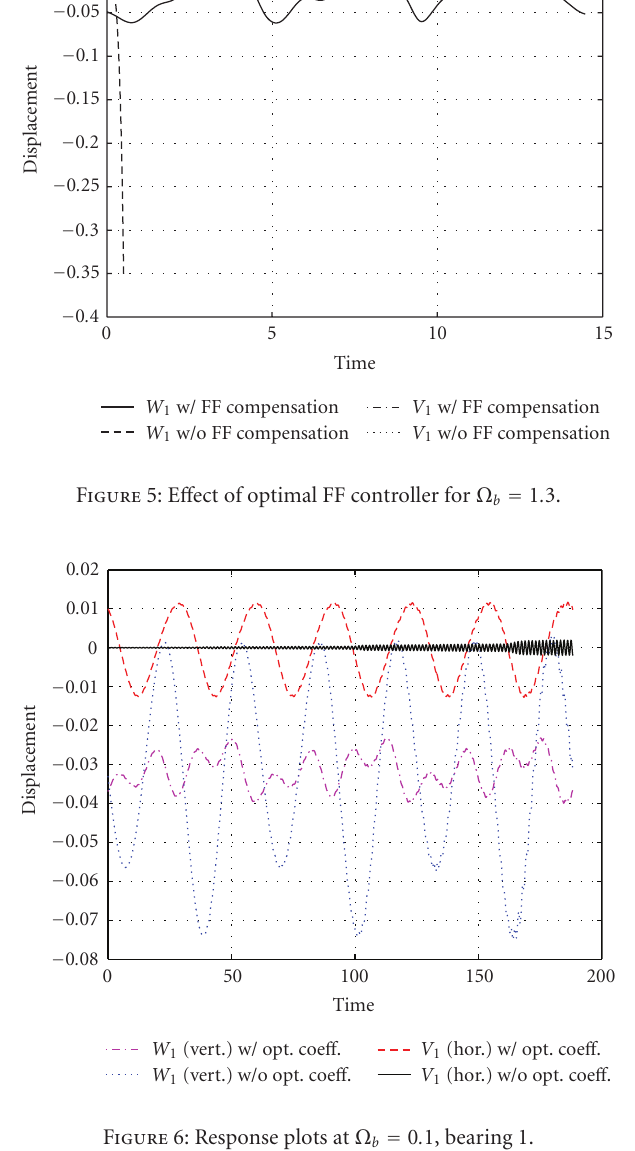
Figure 8: Response plots at Ω b = 1 . 0, bearing